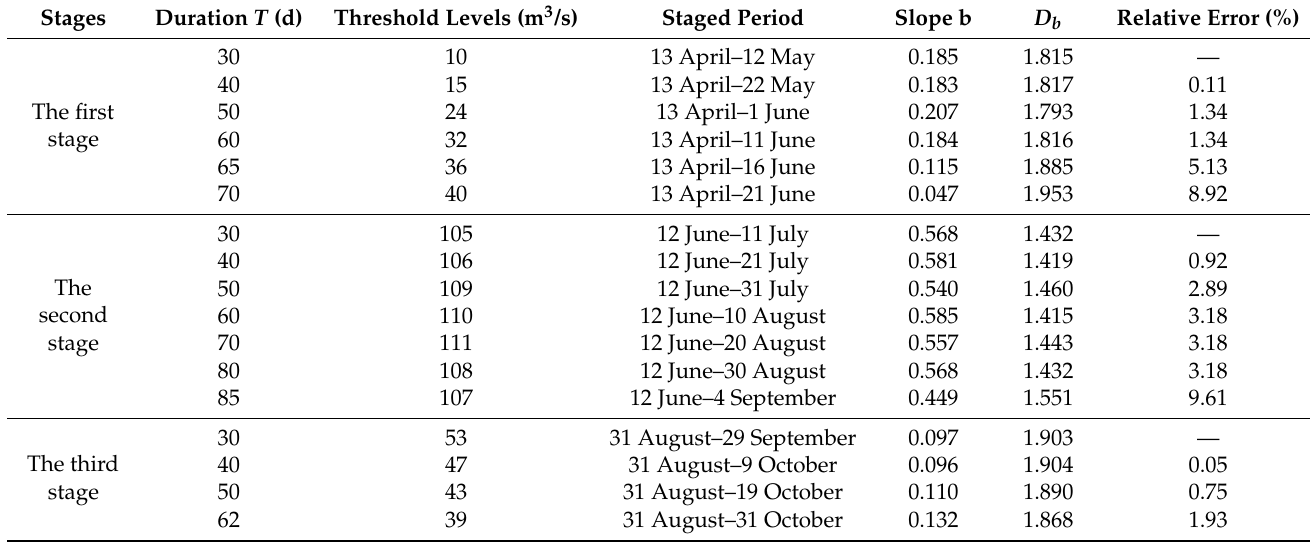
Table 4. Staging results of multi-year average daily runoff.